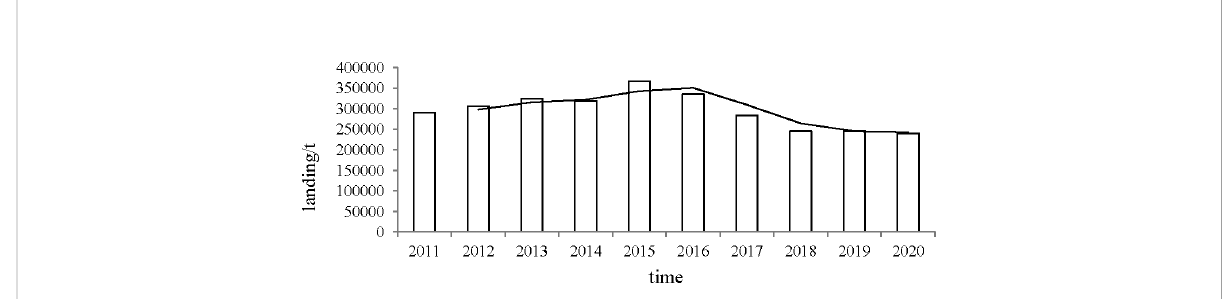
FIGURE 1 Annual landing of cocktail shrimp in China (data from China ’ s Fisheries Statistical